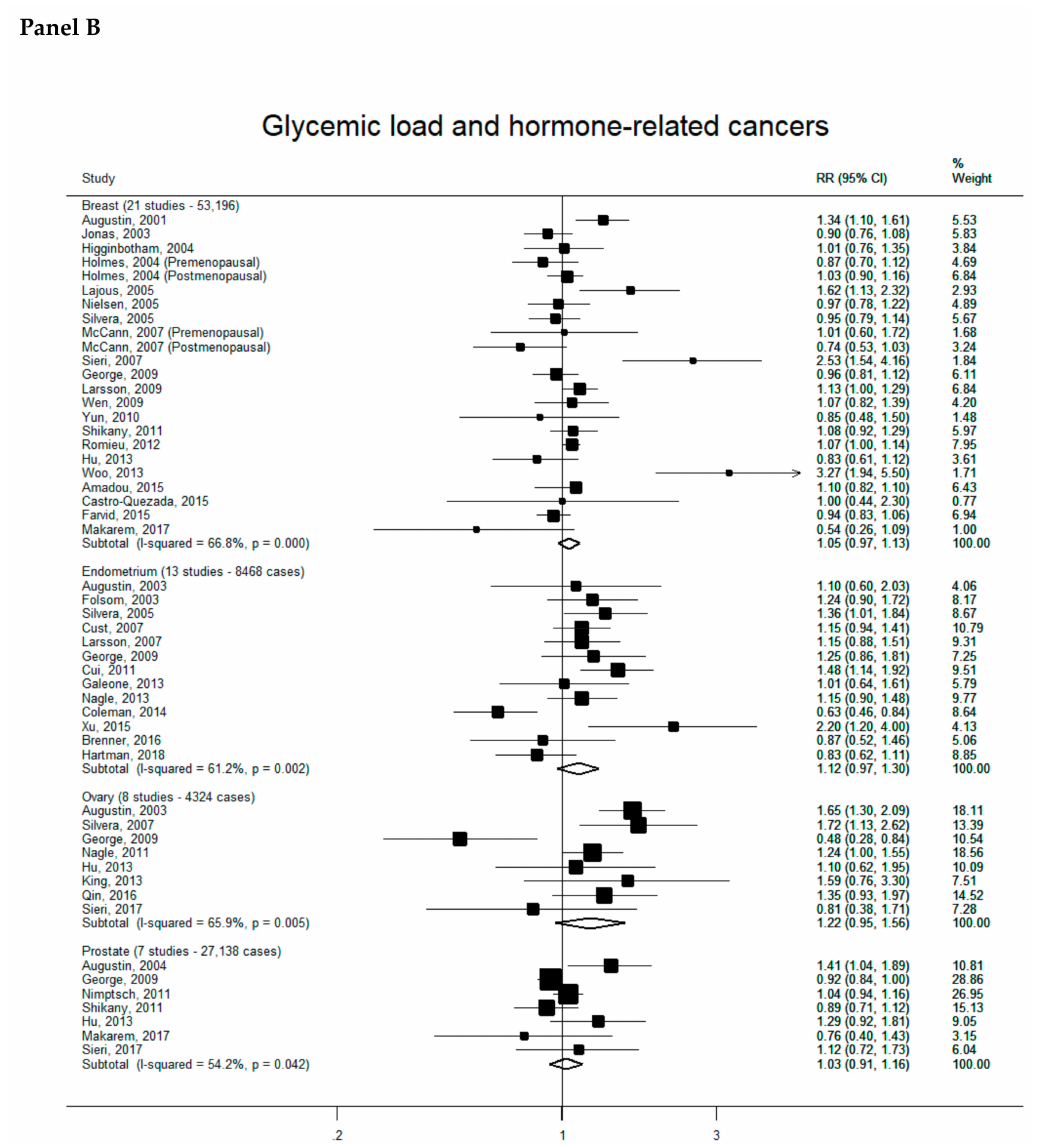
Figure 1. Study-specific and summary relative risks (RRs) of hormone-related cancers for the highest versus the lowest category of glycemic index (Panel A) or glycemic load intake (Panel